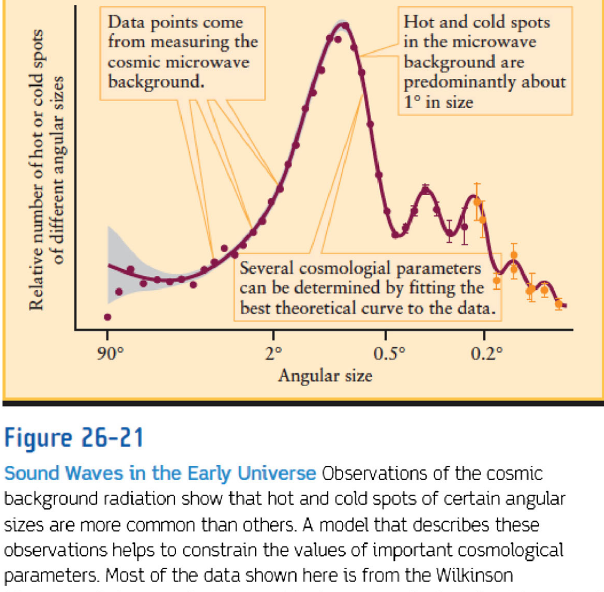
FIG. 35. Power spectrum of the cosmic microwave back- ground, as seen in an introductory astronomy textbook. Image credit: Freedman, Geller, and Kaufmann [101]. Used with